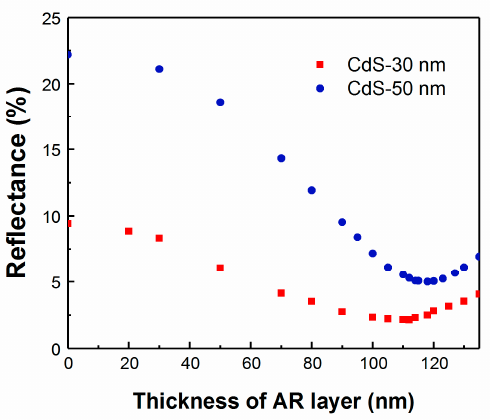
Figure 11. Real-time reflectance for CIGS devices with different layers of CdS thickness.